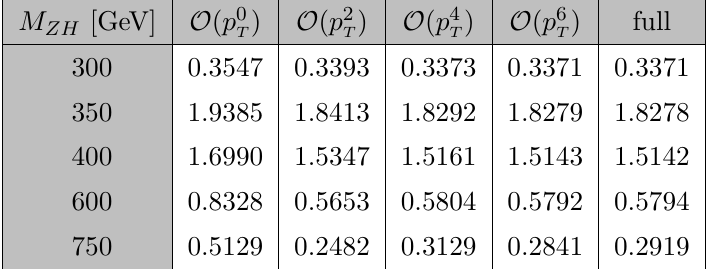
Table 1 . The partonic cross section ˆ σ (0) at various orders in p values of M ZH